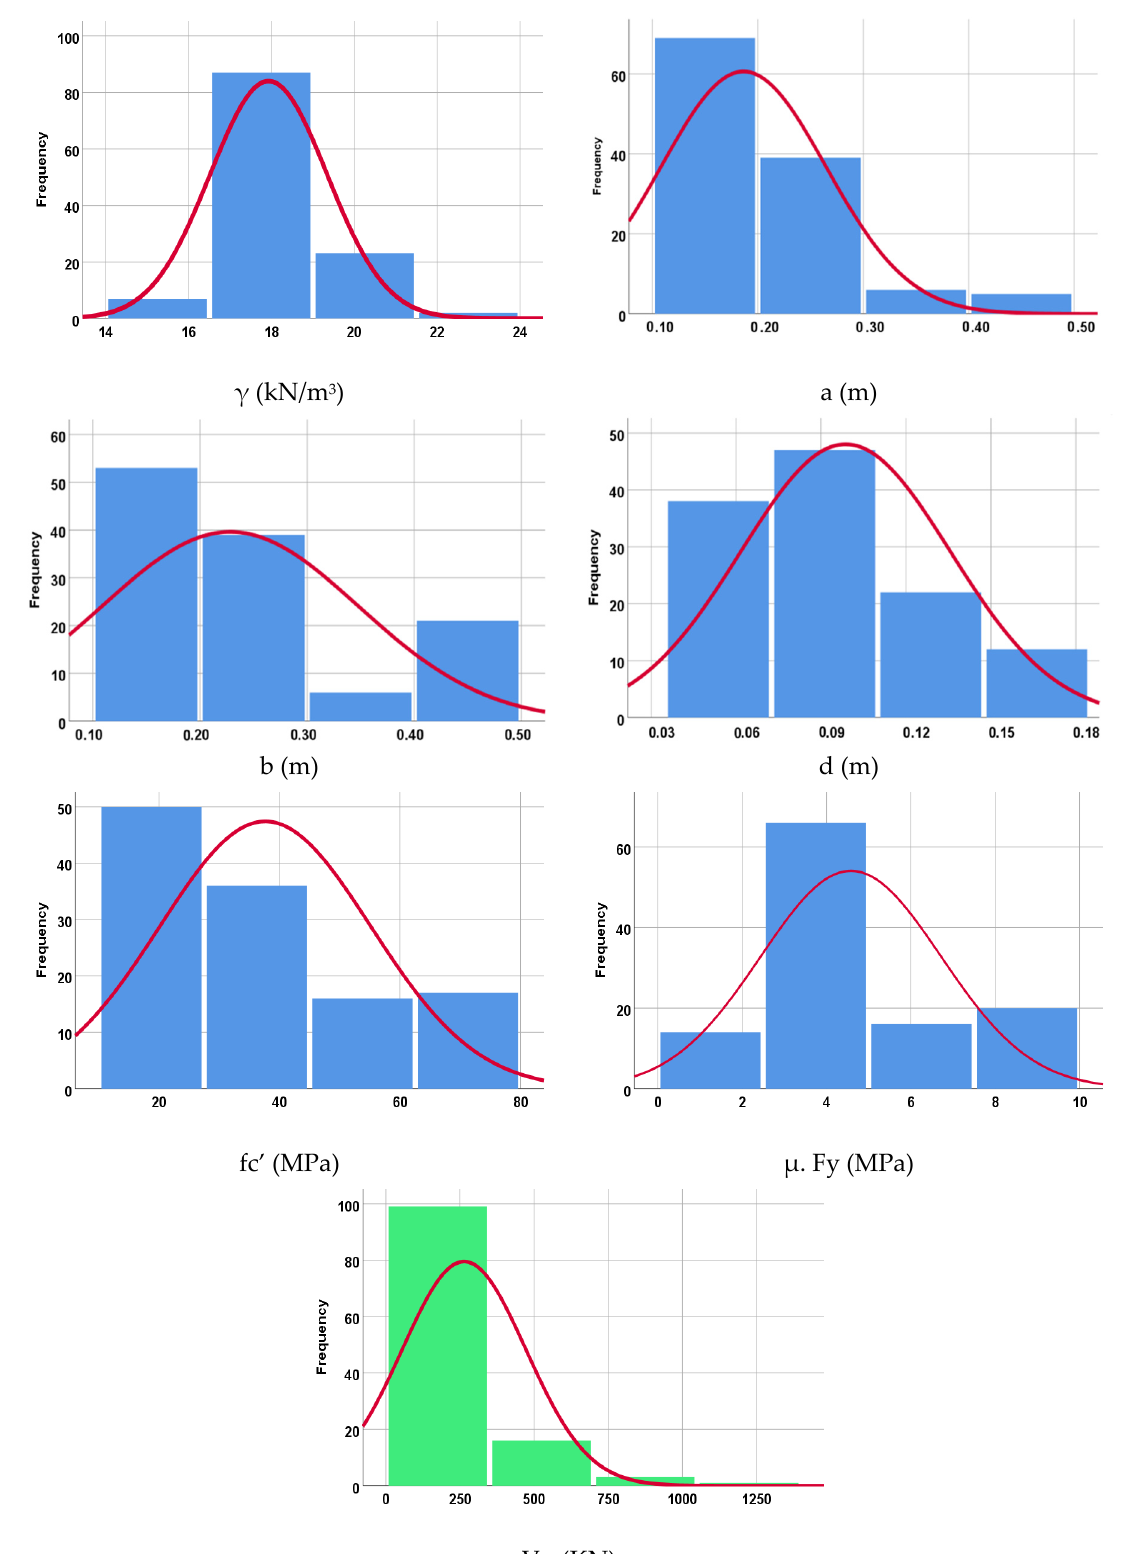
Figure 1. Distribution histograms for inputs (in blue) and outputs (in green). Table 1. Statistical analysis of collected database.